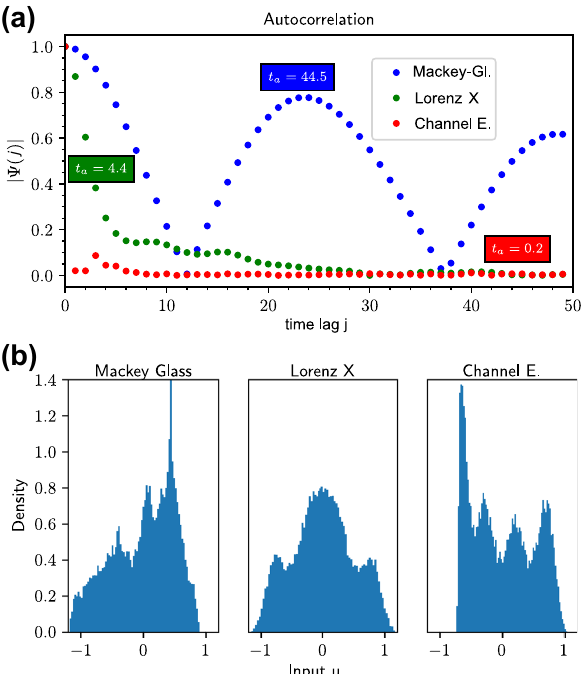
Figure 7: Properties of the input fed into the reservoir: (a) Modulus of the auto-correlation function 𝛹 ( j ) for Lorenz X, Mackey–Glass and channel equalization task, respectively, as a function of the time lag j (colored boxes give the auto-correlation times t according to Eq. (17)). (b) Histograms of the input distributions for three different